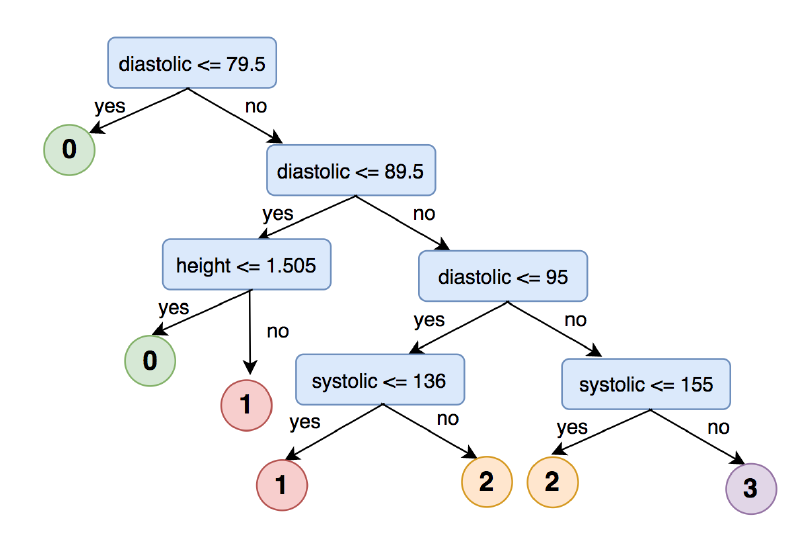
Figure 11. Decision tree of depth 4 for the problem of high blood pressure classification.